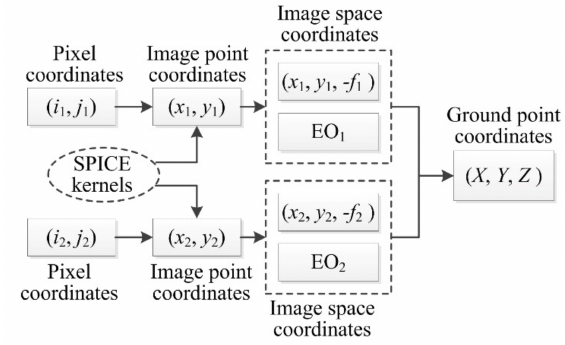
Figure 10. The processing procedure of forward intersection for HRSC linear pushbroom